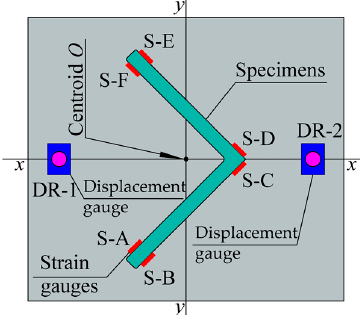
Figure 3. The measurement arrangement of rotation stiffness.